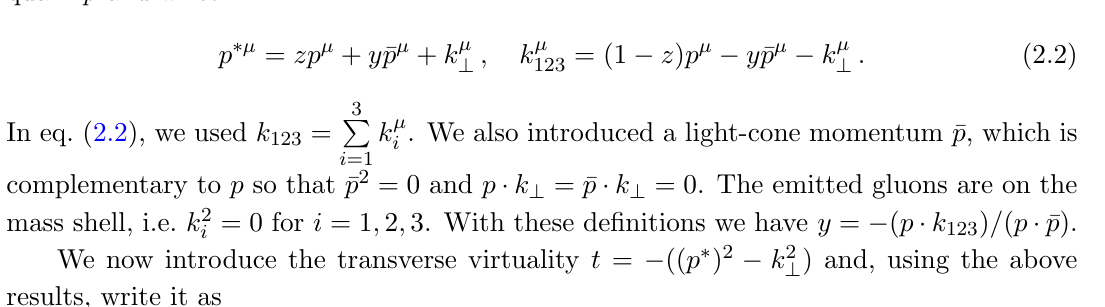
q (cid:3) + q j (cid:22) q j g for i i !